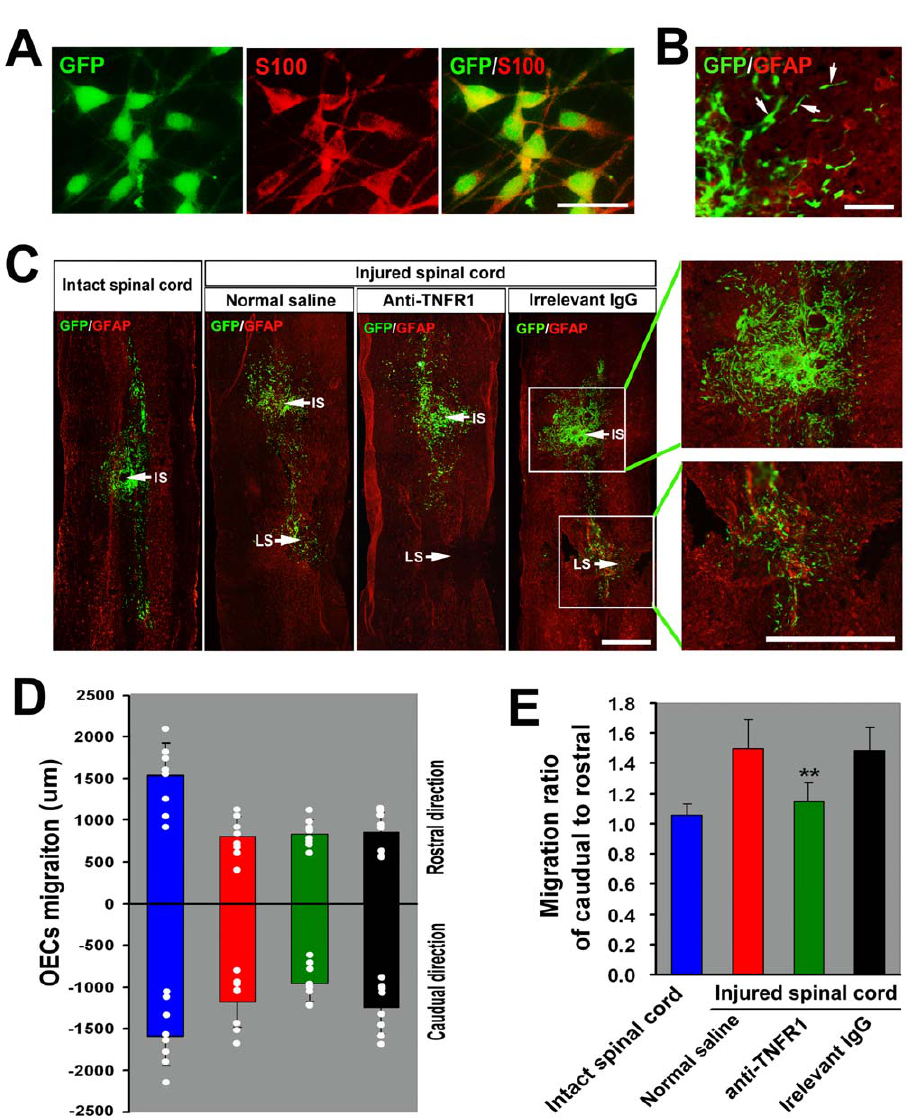
Figure 8. TNF- a attracts implanted OECs migration toward lesion site invivo . (A) S100 immunolabeling of GFP-expressing OECs in vitro . The majority of OECs cultured from GFP-transgenic rats express S100. (B) Higher power showing OECs at the edge of the injection site. Elongated profiles (arrows), suggestive of cell migration, as well as round and multipolar GFP labelled cells can be seen. (C) Horizontal sections from intact and contralateral hemisectioned spinal cords with GFP-expressing OECs injections 1.5 mm rostral to the lesion epicenter at the time of injury. The animals with SCI were treated with normal saline (N.S.), anti-TNFR1 antibody or irrelevant goat IgG every day through a pipe embedded in the subarachnoid space. Arrows indicate the injection site (IS) and lesion site (LS). (D) Quantitative assessment of cell migration at 10 days after transplantation into the spinal cord. Mean and standard deviation of the migration distances in rostral and caudal directions are presented for each group. The white dot indicates the migration distance for each injection. Blue bars, OECs into intact spinal cord; red bars, OECs into injured spinal cord and treated with normal saline; green bars, OECs into injured spinal cord and treated with anti-TNFR1; black bars, OECs into injured spinal cord and treated with irrelevant IgG. (E) Histogram showing the average migration ratio of the caudal to rostral direction. ** P , 0.01 versus normal saline or irrelevant IgG group. Scale bars: 50 m m (A), 100 m m (B), 500 m m (C).